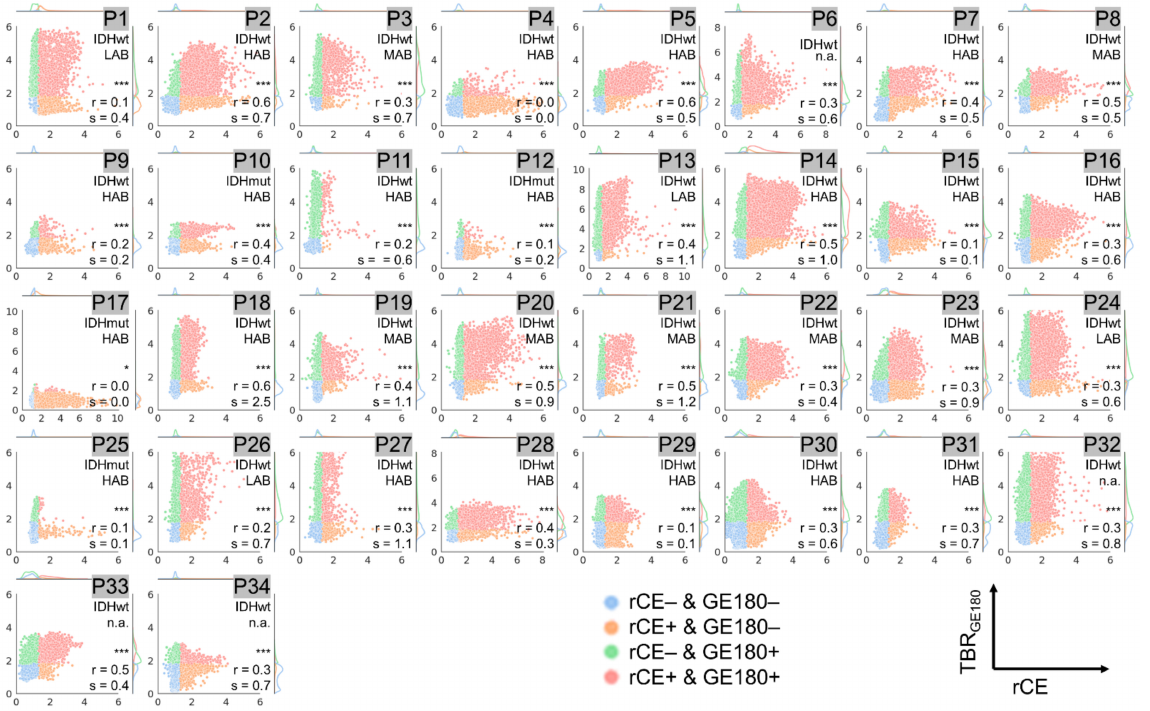
Figure 3. Voxel-wise correlation of [ 18 F]GE180 tumor-to-background ratios (TBR GE180 ) vs. relative contrast enhancement (rCE) values for patients P1–P34. The depicted data points are color coded as described in Figure 2: Red: rCE and TBR GE180 positive voxels, Blue: rCE and TBR GE180 negative voxels, Orange: rCE positive and TBR GE180 negative voxels, Green: rCE negative and TBR GE180 positive voxels. Significances obtained from Pearson’s correlation and the corresponding correlation coefficients (r) and slopes (s) are provided in the lower right corner. Significance was grouped as strong ( p < 0.001, denoted with ***), and low ( p < 0.05, *). The status of IDH mutation (IDHmut: with IDH1/2 mutation; IDHwt: without mutation) and the TSPO-polymorphism genotype are given for each patient in the upper right corner (if not available denoted with n.a.). The axis ranges are all fixed to values between zero and six except for patients P6, P13, P17, and P28 where the upper limit was adapted due to higher voxel